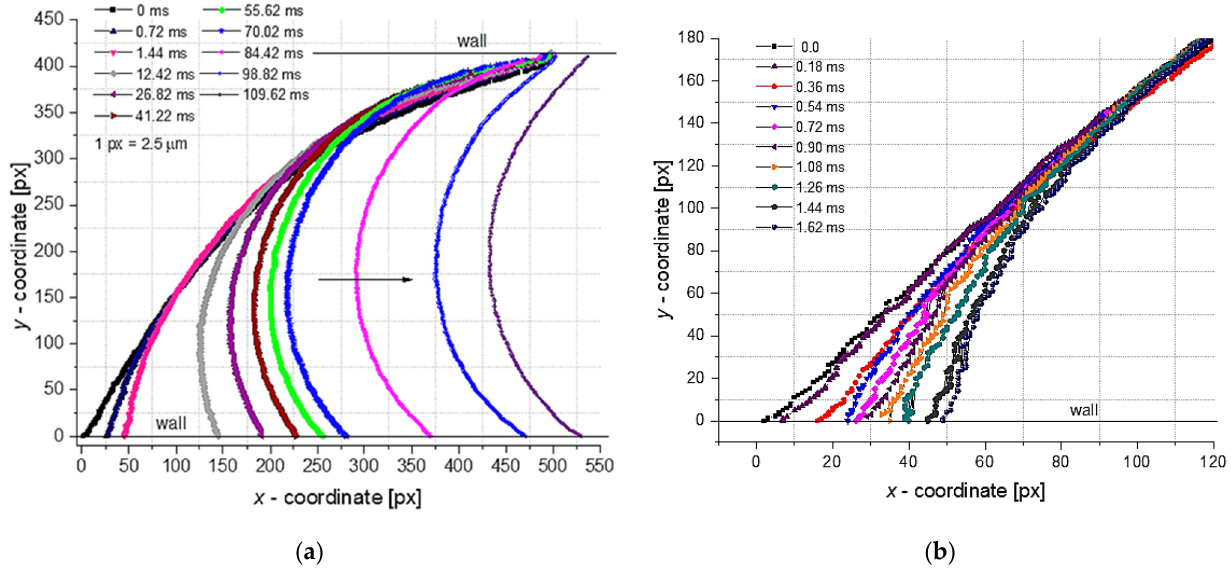
Figure 10. Dynamics of the droplet interface after breakup at 0 < t < 110 ms, with detail of the interval 0 < t < 1.7 ms. It is assumed that for time t > 110 ms the local geometry of the droplet interface will remain constant. ( a ) interface aspect from interface rupture (0 ms) to droplet symmetry (109.62 ms); ( b ) detail of the interface in the first 1.62 ms after rupture. Using the data from Figure 10, the time variations in (i) space position x A , (ii) slip velocity v s and (iii) contact angle α o are represented in Figure